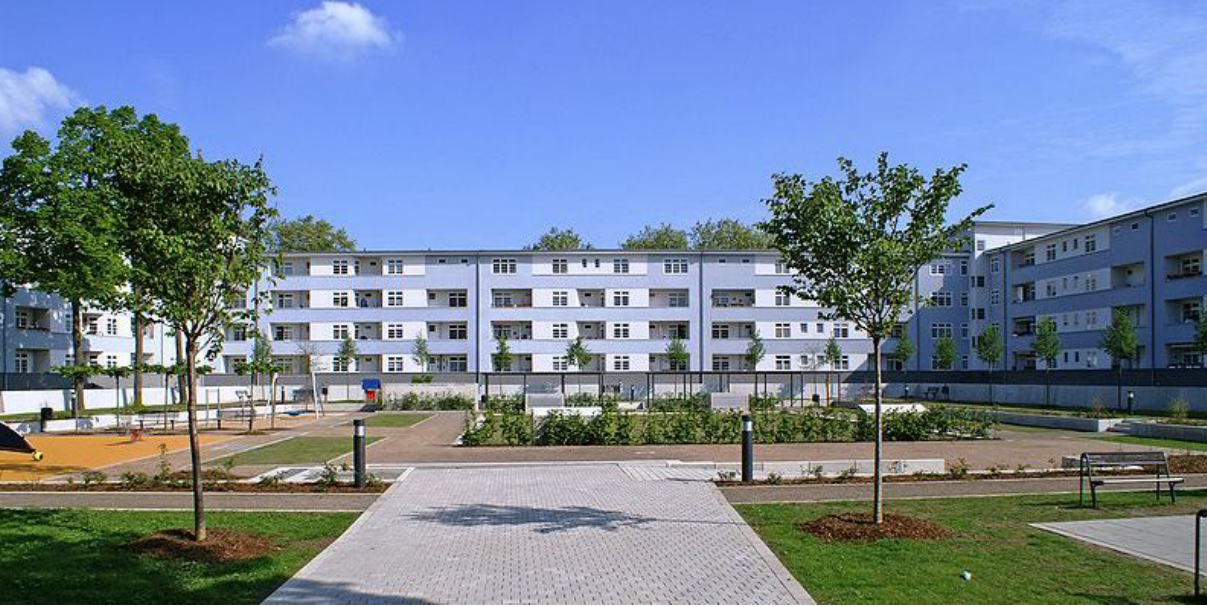
Figure 14. W. Riphahn, Blauer Hof , Cologne-Buchforst, 1926–1927. Interior courtyard. Source: Heinrich